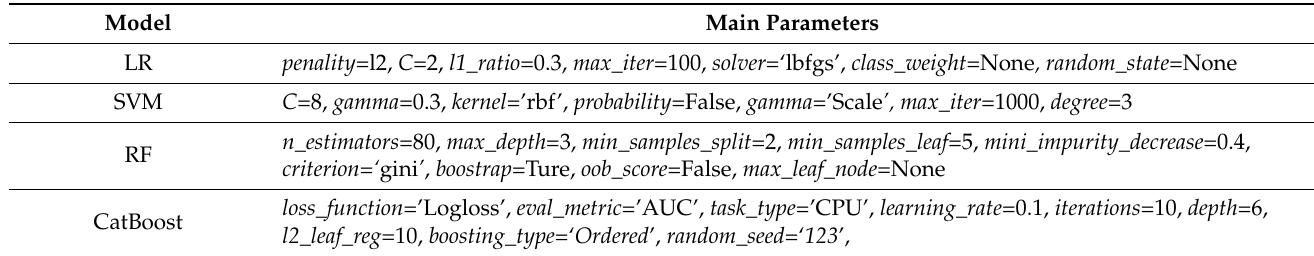
Table 7. Main parameters of different models.